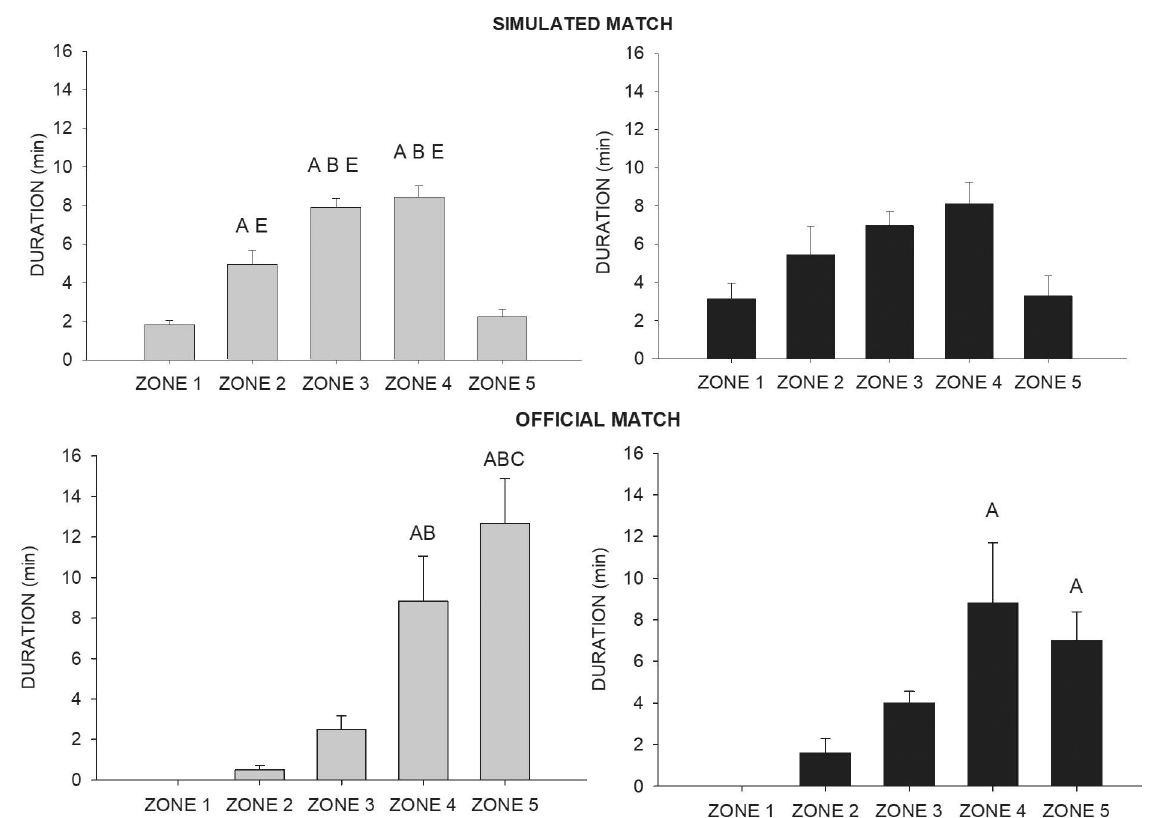
Figure 3 - Duration of time in the HR zones (min) reached in the multi-shuttlecock, technical-tactical, physical, simulated match, and official match for the female and male athletes. A, significant difference in the multi-shuttlecock training; B, significant difference in the technical-tactical training; C, sig- nificant difference compared to physical training; D, significant difference compared to the official matches (p <